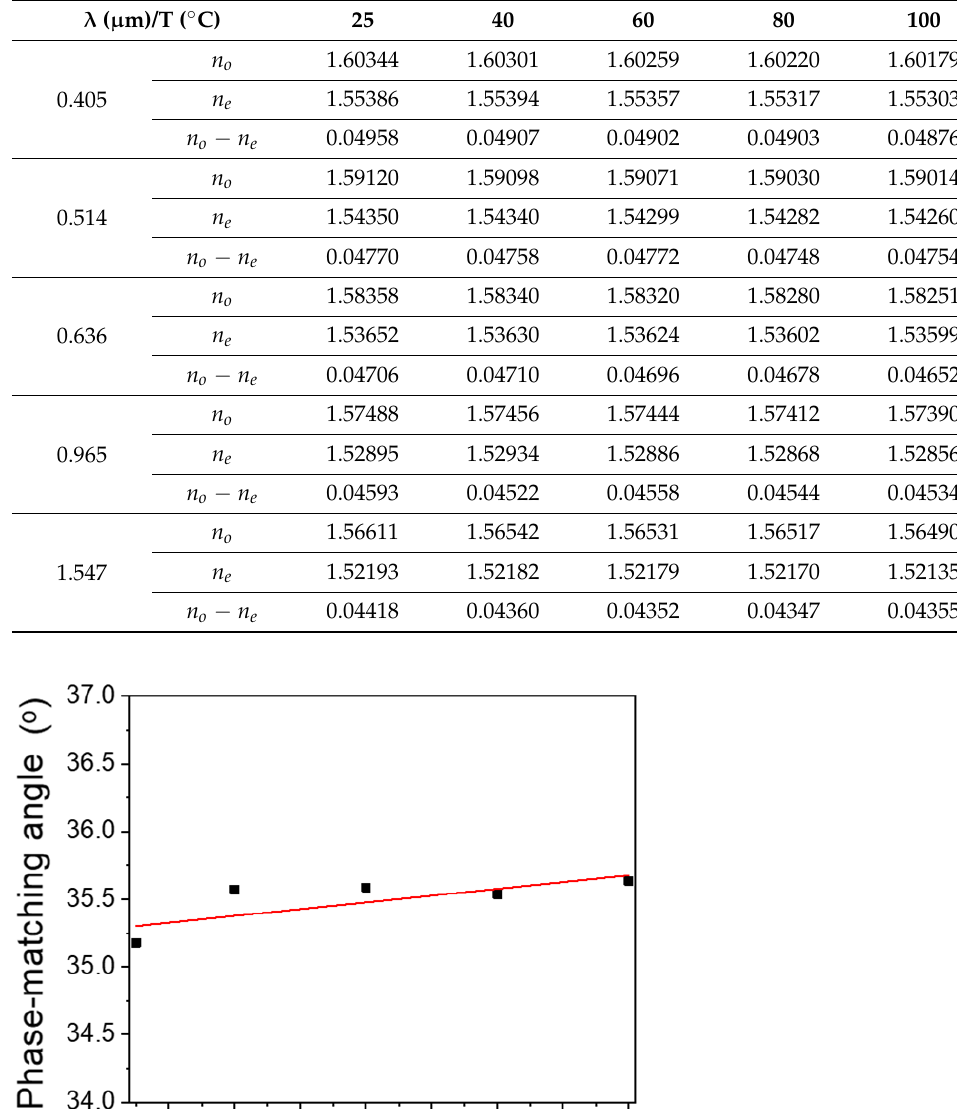
Table 1. Thermal refractive index at different temperatures.